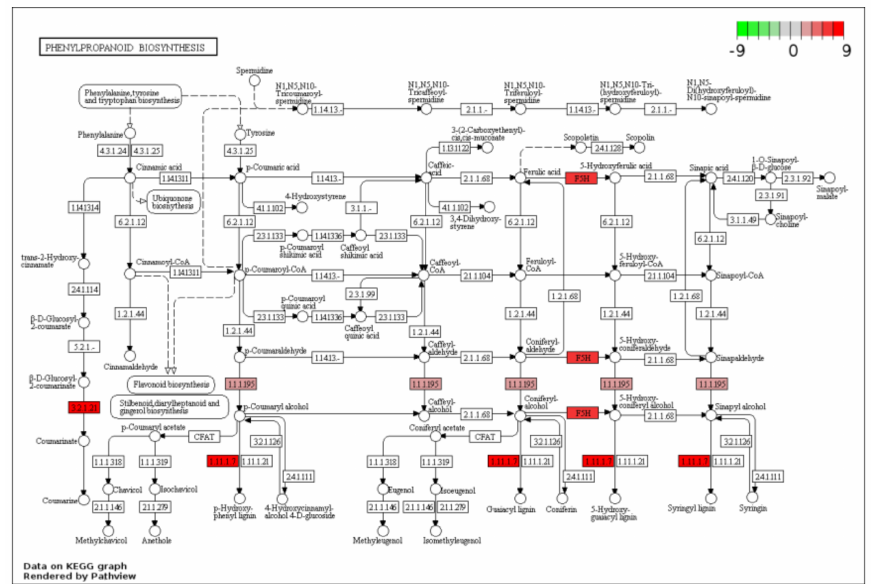
Figure 4. Gene expression in the phenylpropanoid biosynthesis pathway plotted by PATHVIEW. Red represents upregulated genes, while green represents downregulated genes. The depth of color indicates the relative expression level of these genes.